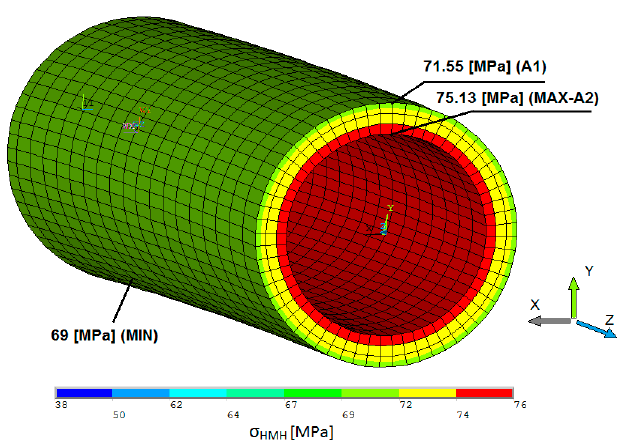
Figure 8. Distributions of equivalent stresses after 200,000 h ( T = 665 ◦ C).